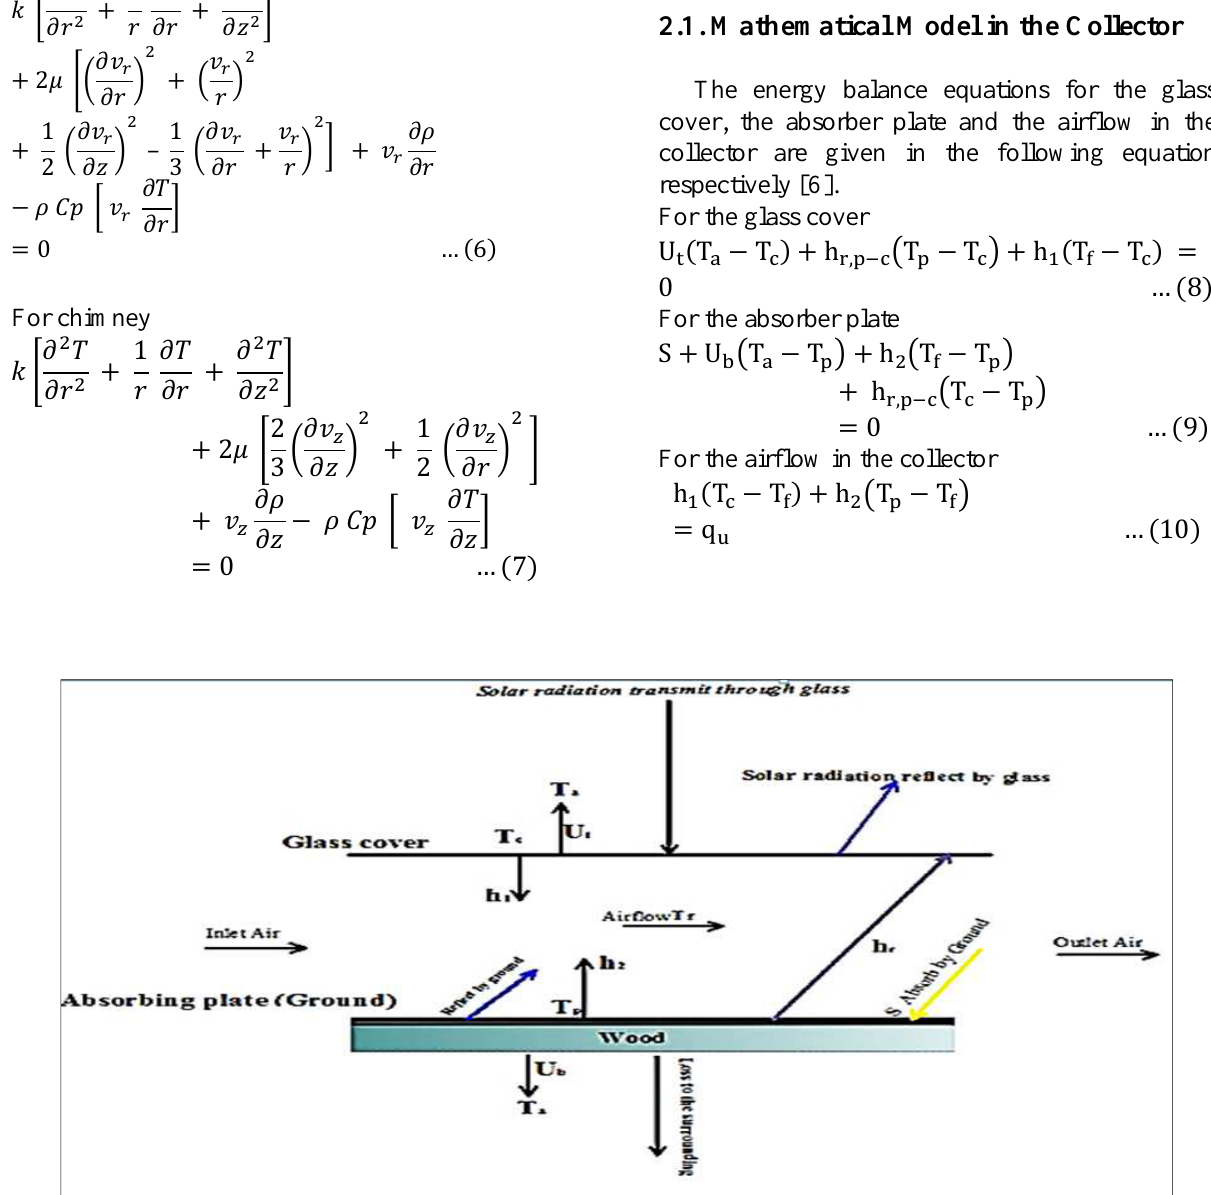
Fig. 3. Heat transfer scheme of solar collector.